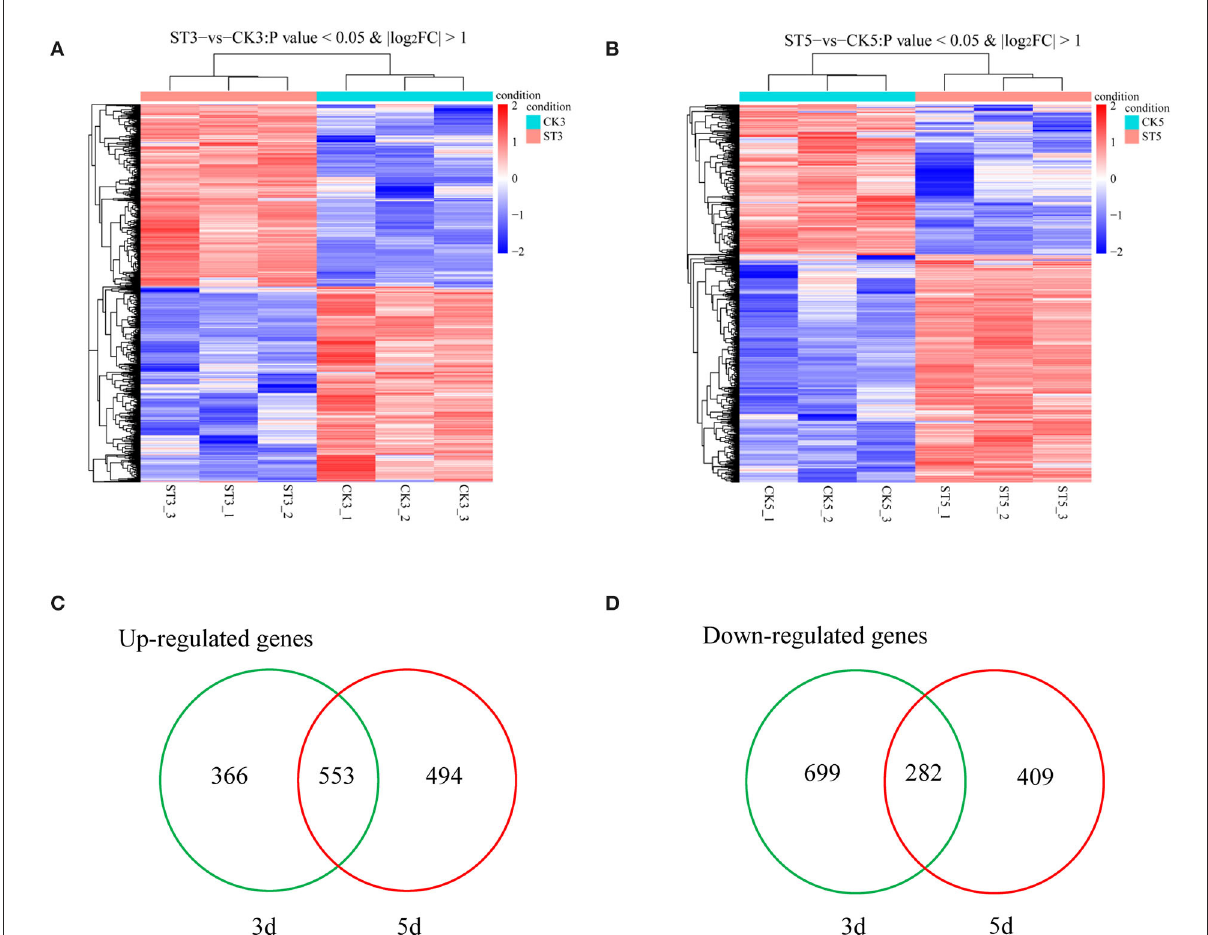
FIGURE2 Analysis of transcripts in rice shoots in the control (CK) and salt treatment (ST). Cluster analysis of specifically expressed mRNAs at (A) 3 and (B) 5 d after treatment. Venn diagrams of (C) up-regulated and (D) down-regulated genes between 3 and 5 d after salt